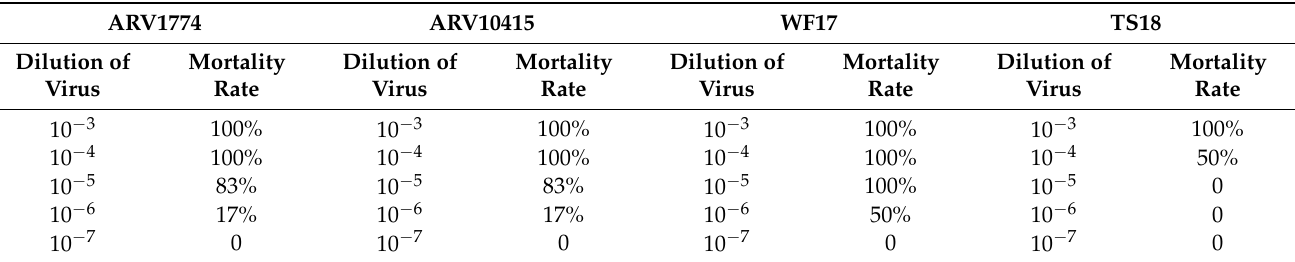
Figure 2. RT-PCR results of Avian reovirus virus (ARV)-infected LMH cells. M: DL2000 Marker; 1- Table 4. Mortality rate of SPF chicken embryos infected with virulent 13: ARV isolates; +: Positive control; -: Negative control.